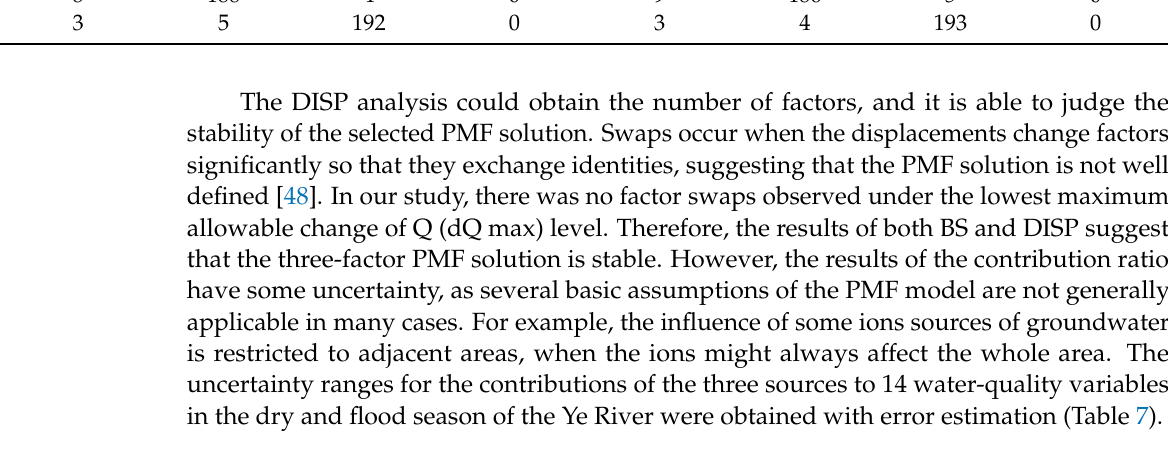
Table 7. Results of uncertainty analysis for factor contributions ratio (%) to 14 water-quality parame- ters in the Ye River of Hebei Province, China using the error estimation methods of displacement of factor elements